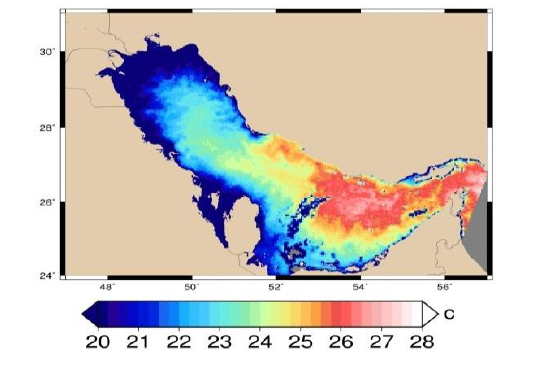
Figure 1. SST image in 28 Dec 2010, 22:50